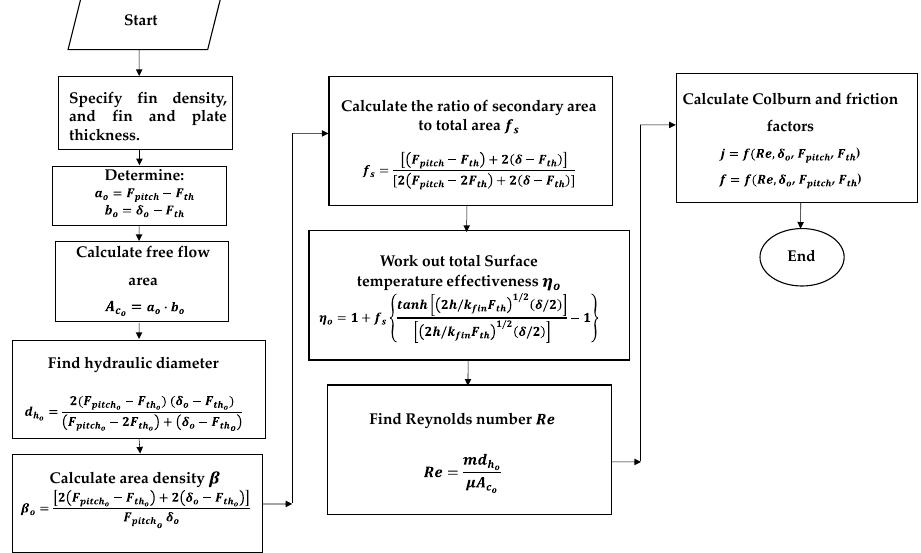
Figure 2. Block diagram of the overall finned surface design process.